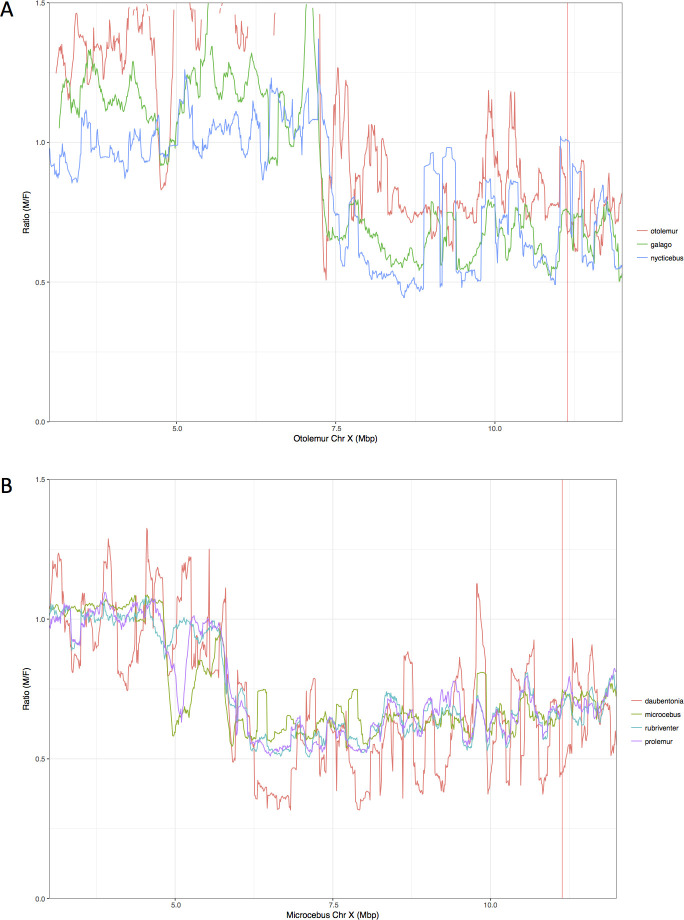
Zoom-in on the inferred PABs.(A) Combined M:F read depth ratio for northern greater galago (red), senegal bushbaby (green), slow loris (blue). (B) Combined M:F M:F read depth ratio for aye-ayes (red), grey mouse lemur (blue), red-bellied lemur (light blue), greater bamboo lemur (purple). Position of the PABs in lemurs and lorises is the same (see legend of Figure 1 for more details). Positions of the PABs in Mb shown here differ because of differences in the X chromosome assembly between M. murinus and O. garnetti.